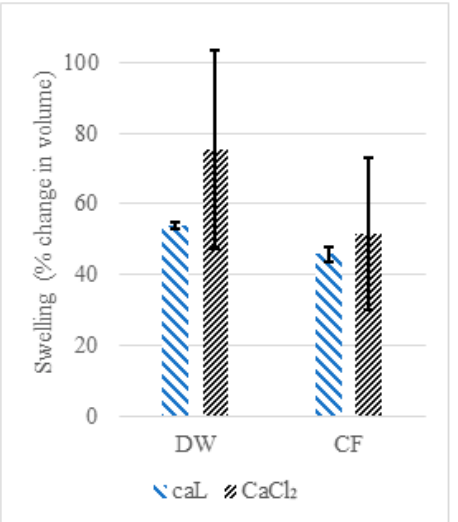
Figure 4. Swelling of CaAlg capsuled prepared using either CaL or CaCl 2 in water or CF after 14 days.